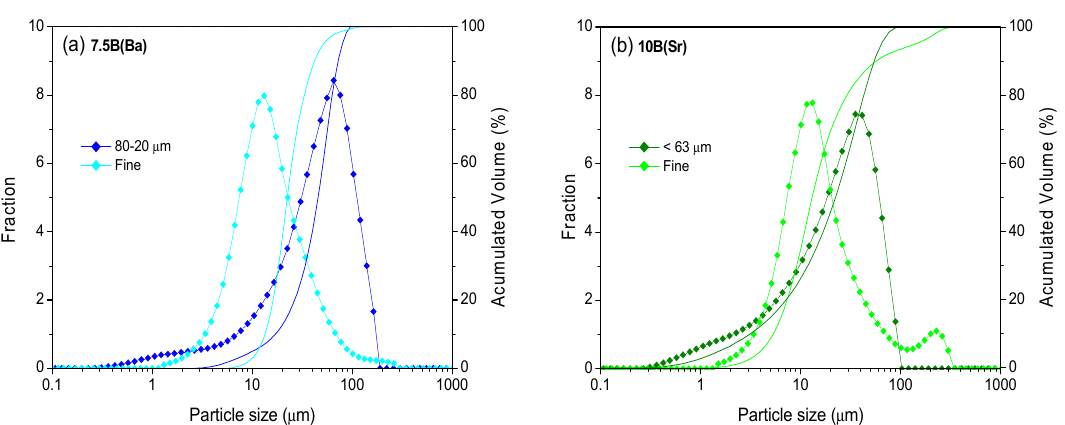
Figure 1. Particle size distribution of the two studied fractions ( a ) 7.5B(Ba) and ( b ) 10B(Sr). Table 2. Particle sizes of the glass powders (± 0.5 µm).